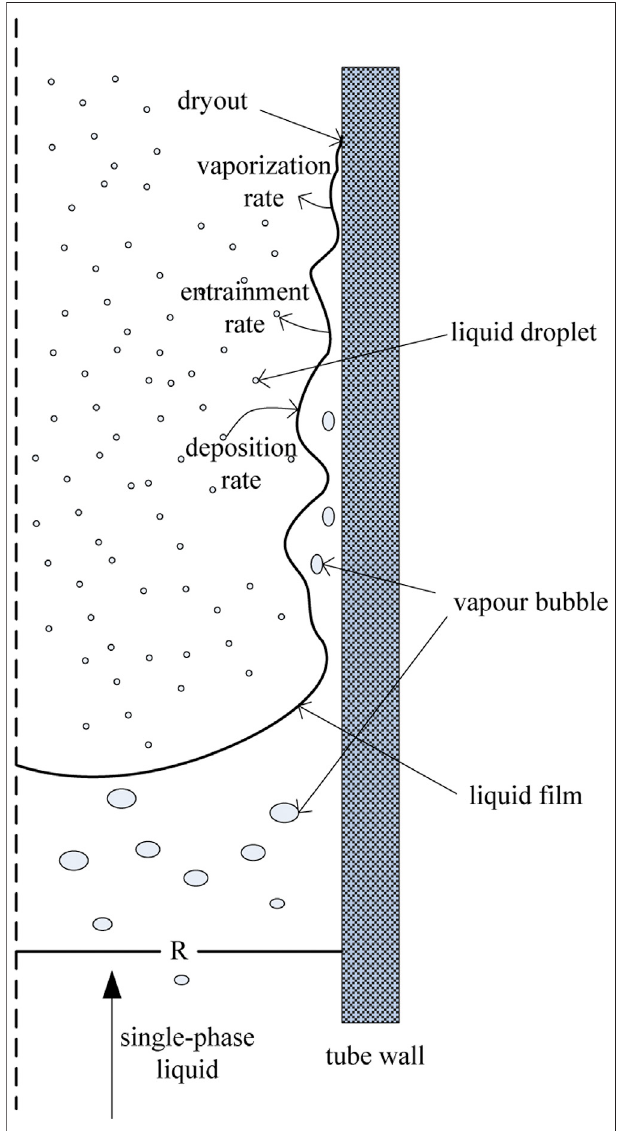
FIGURE 5 | Schematic diagram of the DO